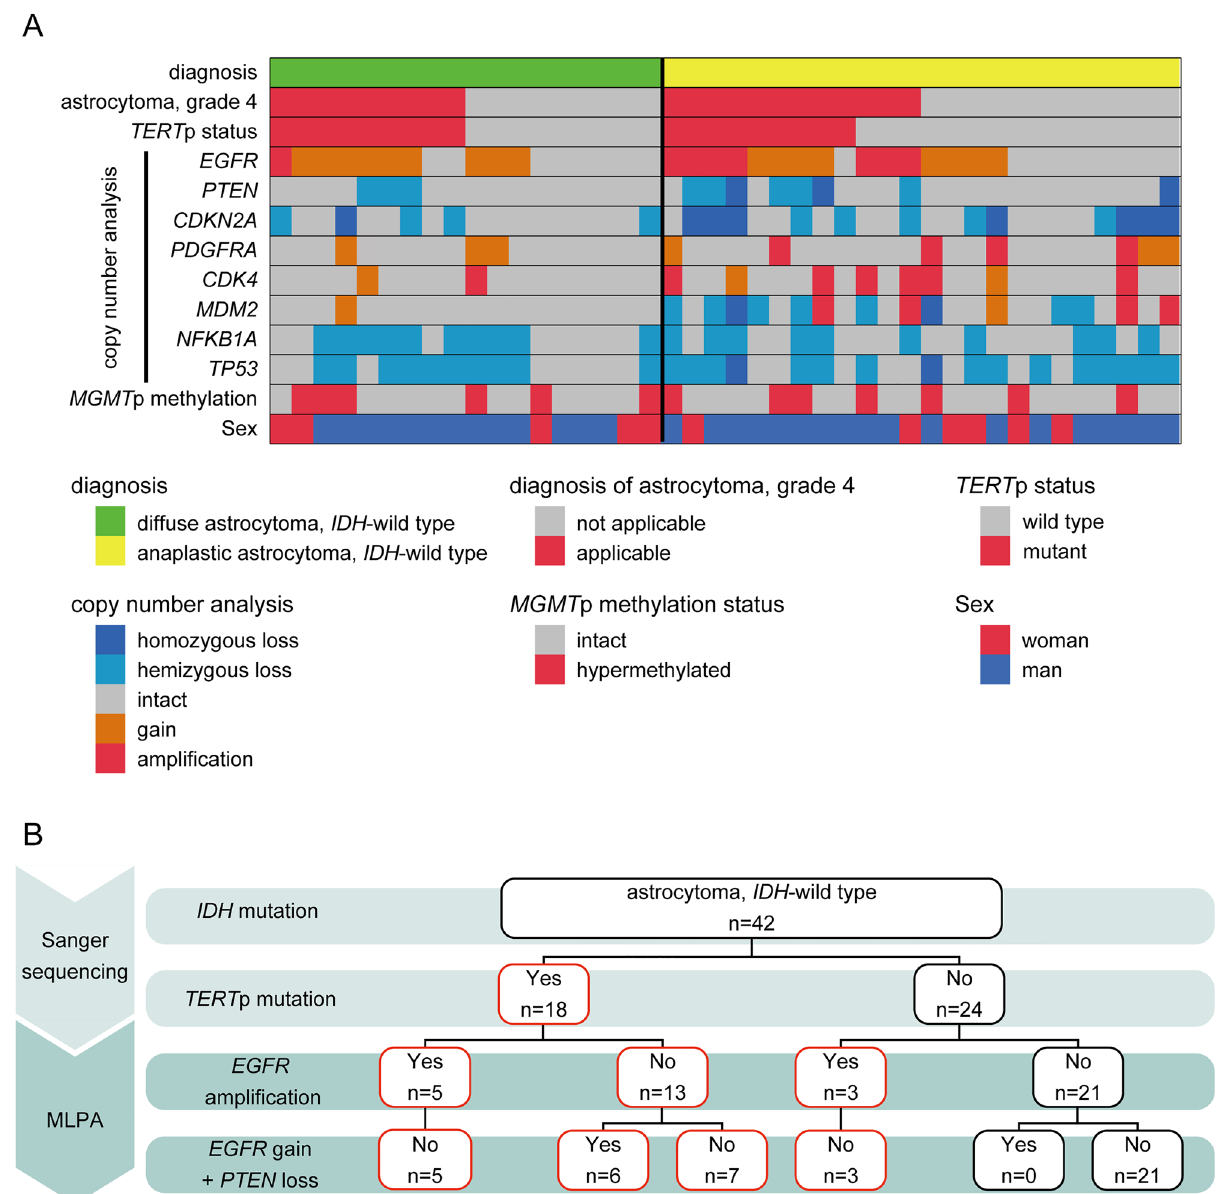
Figure 1. ( A ) The cell plot shows characteristics of all 42 IDH -wild-type astrocytomas. ( B ) The schema of three step classification of IDH -wild-type astrocytomas. TERT p mutation was examined by Sanger sequencing, and EGFR amplification and combination of EGFR gain and PTEN loss were examined by multiplex ligation- dependent probe amplification (MLPA). The case with red square was diagnosed as “astrocytoma. grade